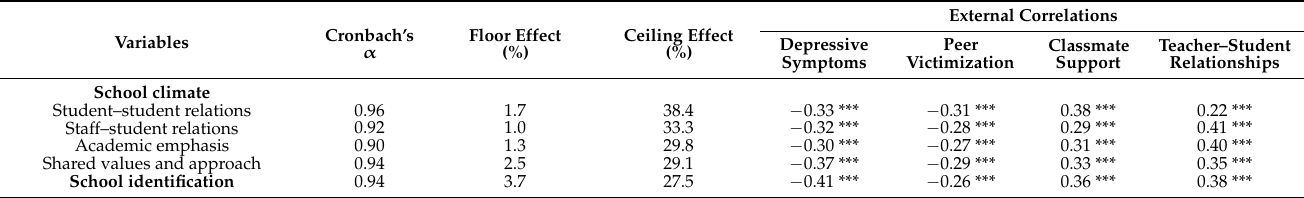
Table 2. Internal consistency, floor and ceiling effects, and external